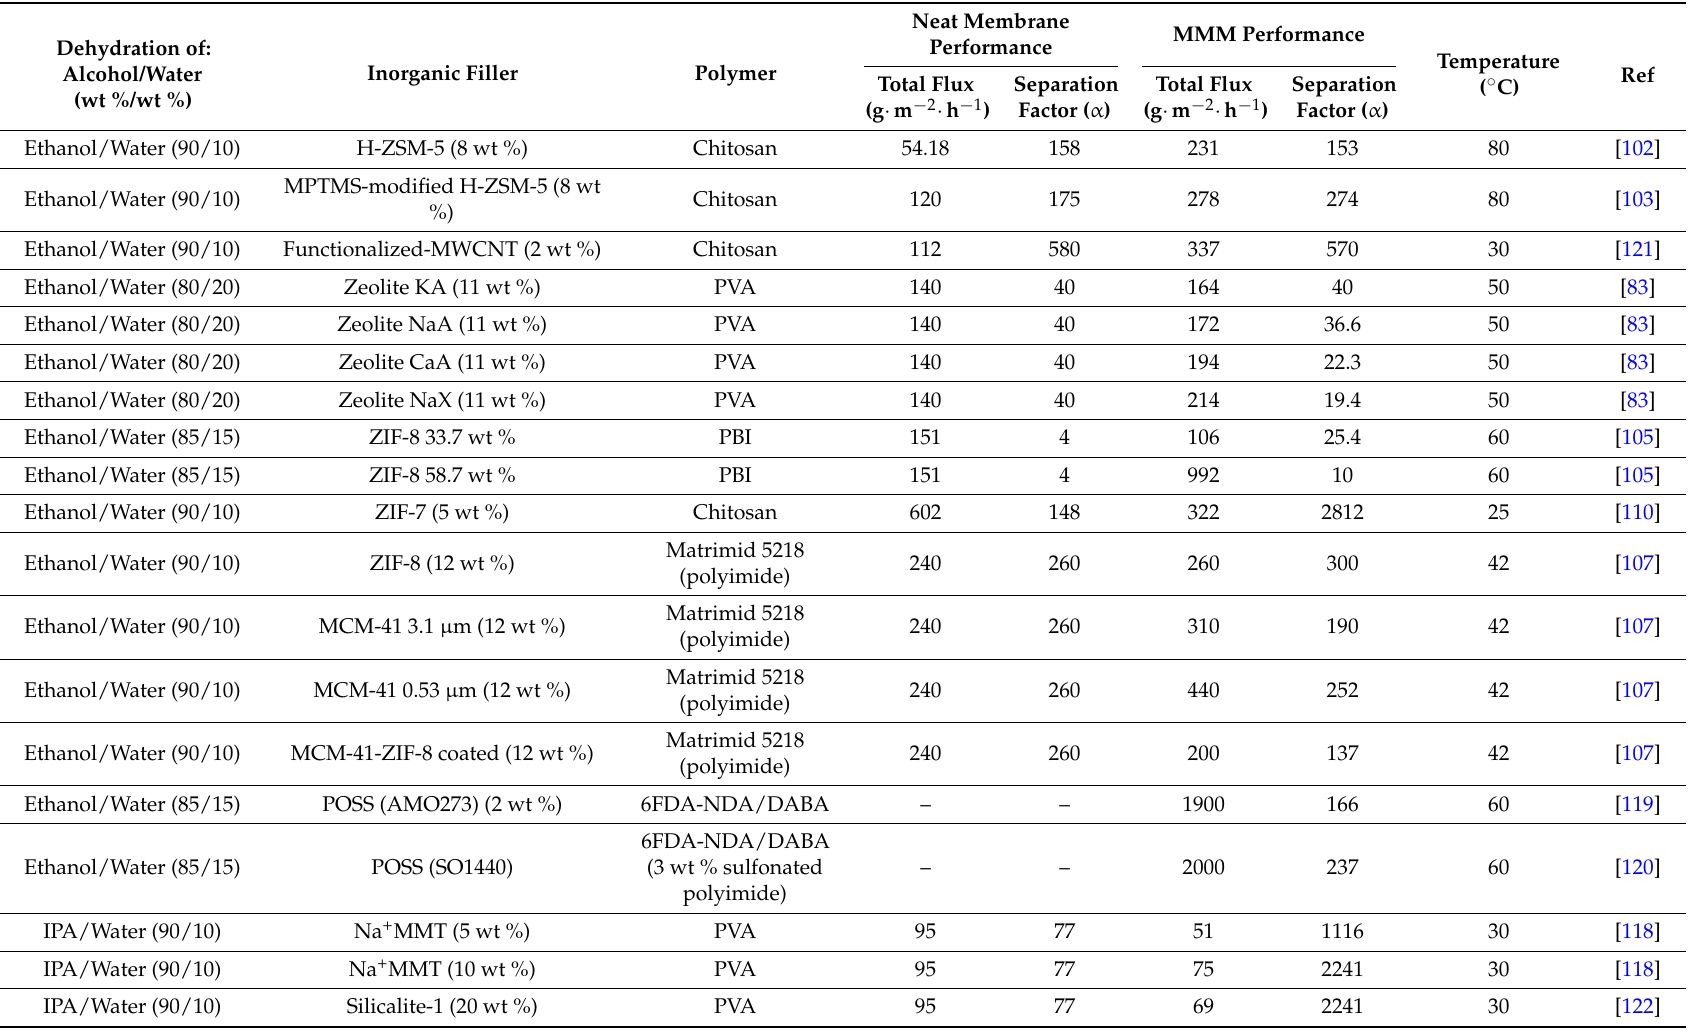
Table 4. Examples of MMMs for hydrophilic